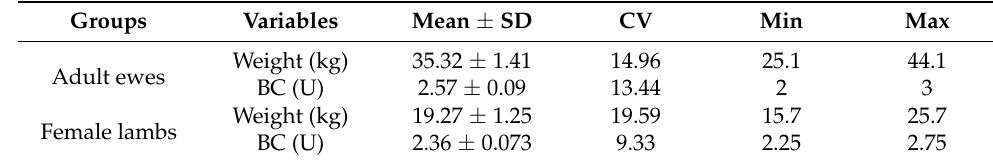
Table 1. Average weight and body condition (BC) of the experimental groups.